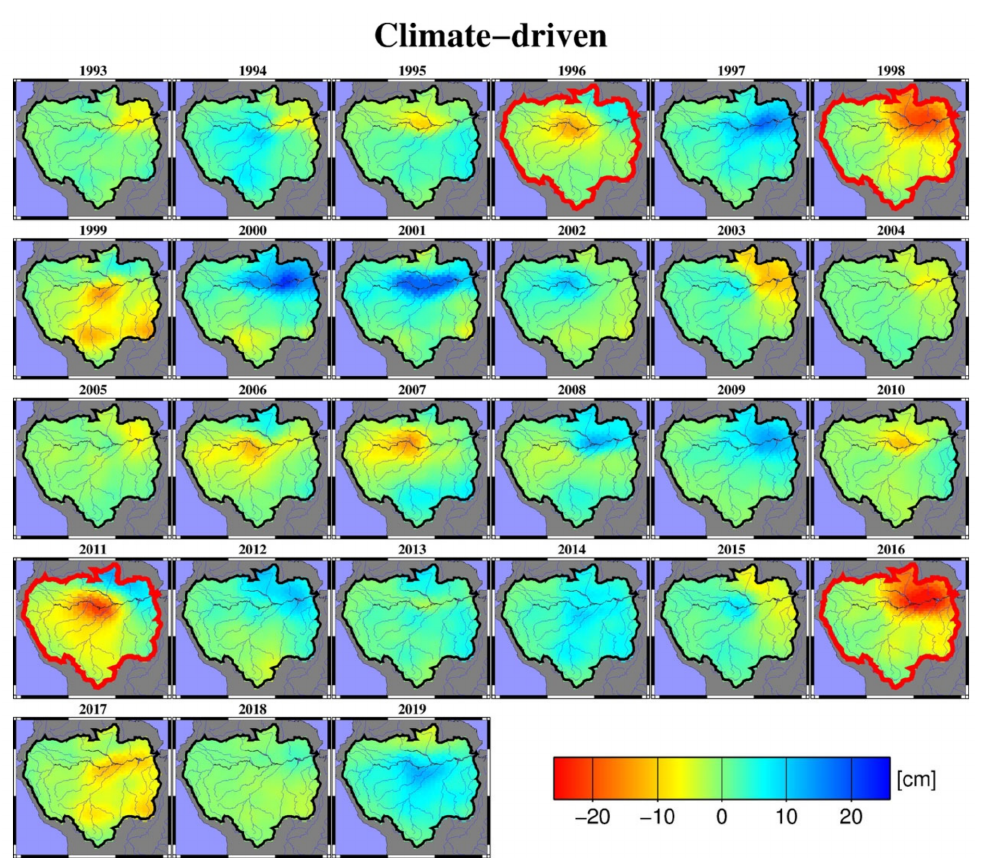
Figure 6. Yearly drought patterns as interpreted from the climate-driven TWSC. Note that the yearly drought patterns are the mean nonseasonal TWSC from July of the previous year to June of the current year (e.g., the 1993 drought patterns are the mean during July 1992 through June 1993).